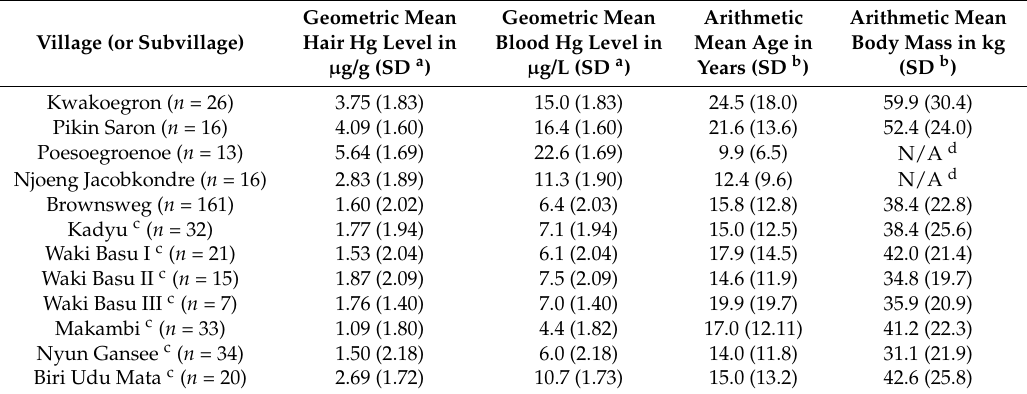
Table 1. Levels of mercury in hair and estimated levels in blood from women and children from interior villages in Suriname. Average age and body mass are reported as